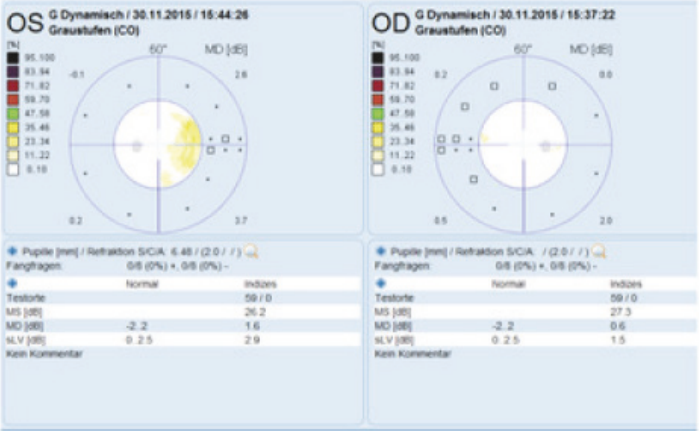
Figure 2: Octopus perimetry confirms the nasal defect on the left